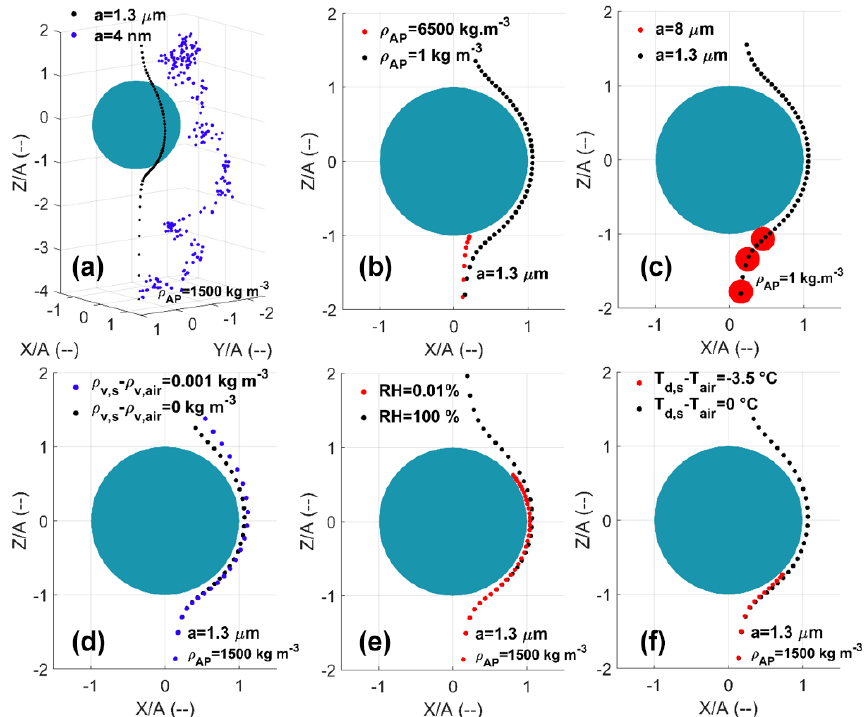
Figure 1. AP trajectories computed with the extended Dépée et al. (2019) model for a 50µm droplet radius ( A ) and AP with various radii ( a ) and densities ( ρ AP ). The air temperature ( T air ) and the air pressure ( P air ) are − 17 ◦ C and 540hPa respectively. The panels indicate the effects of Brownian motion (a) , inertial impact (b) , interception (c) , diffusiophoresis (d) , combined thermophoresis and diffusiophoresis (e) , and thermophoresis (f) . Red trajectories result in an AP collection. (d, f) The gradients are equivalent to a relative humidity of 0.01% (when there is no gradient the equivalent relative humidity is 100%). ρ v,s and ρ v,air are the vapour densities at the droplet surface and in the bulk air,